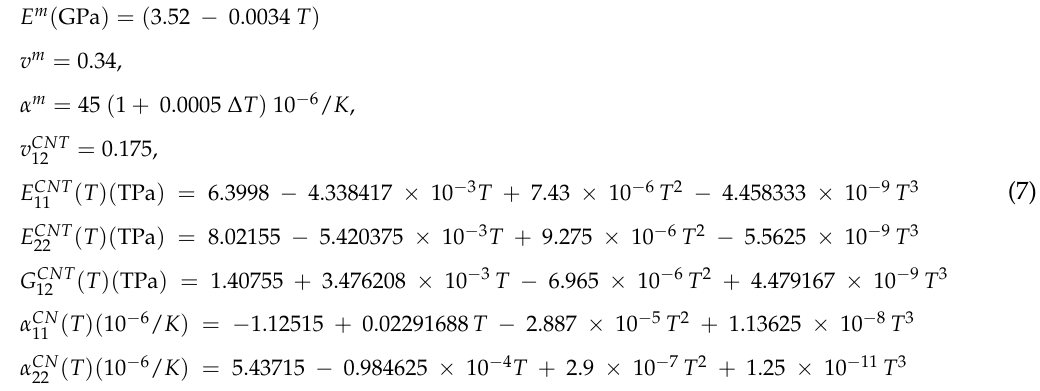
Figure 2. Sigmoidal distributions of the V CNT through the thickness for different exponents s . CNT: Carbon NanoTubes.